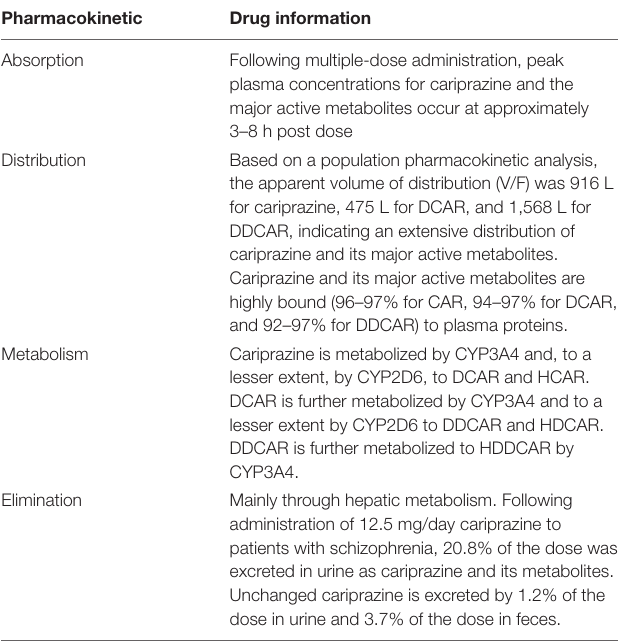
TABLE 2 | Pharmacokinetic proprieties of cariprazine.